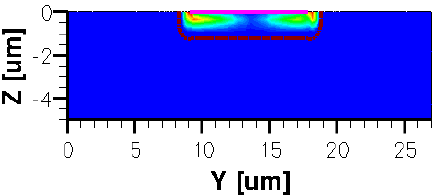
Figure 17. Conduction current density for basic cell (X = 3.25).